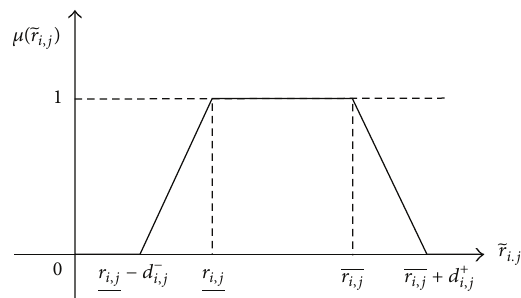
Figure 1: Membership function of the degree of fulfillment by Mikhailov [1].